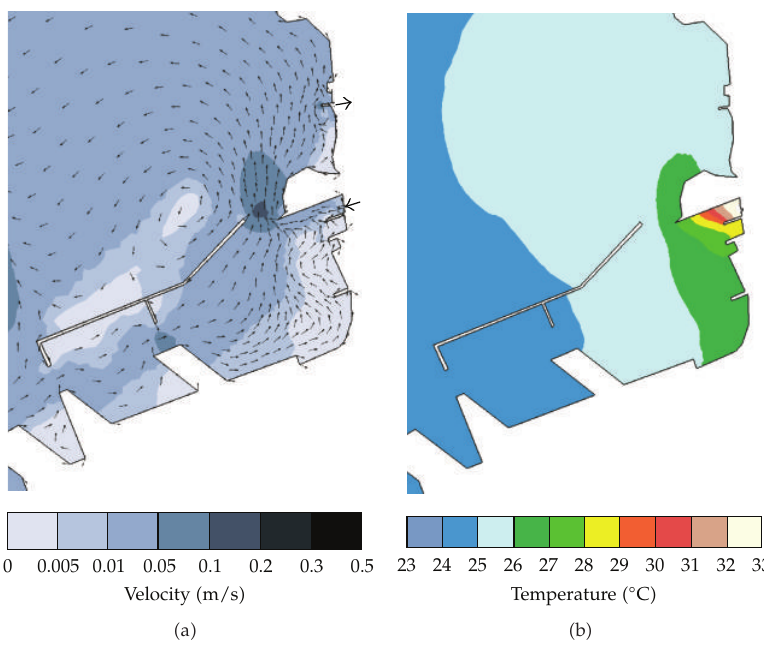
Figure 14: Velocity field and temperature field obtained with the model for the March 30th 14:00 hours with the 6th unit of the power plan in operation.